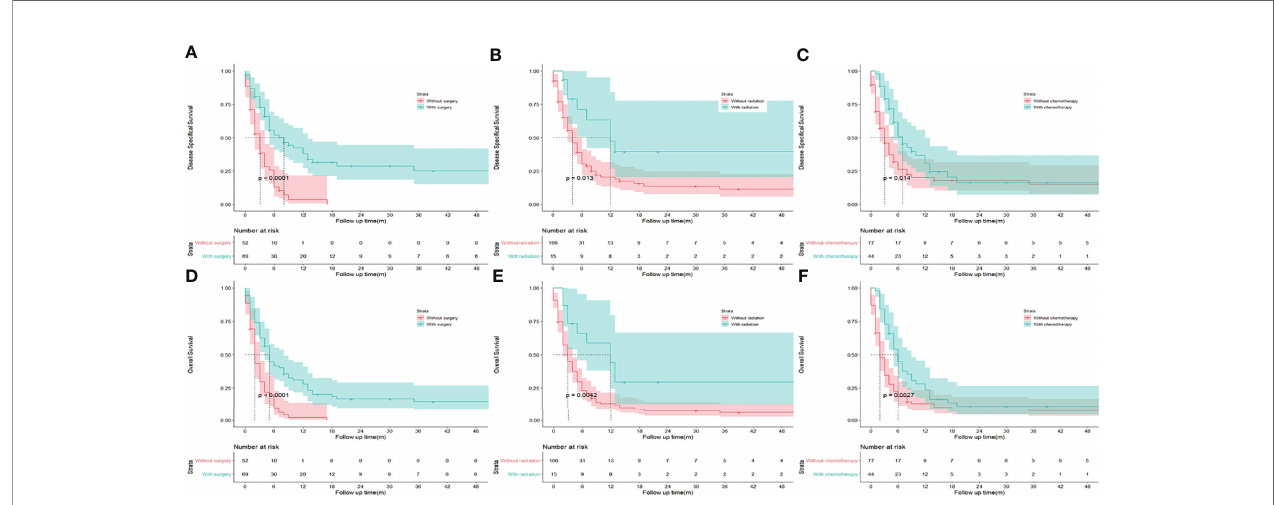
FIGURE 2 | Kaplan-Meier analysis of disease speci fi cal survival and overall survival between patients underwent surgery (A, D) , radiation (B, E) , and chemotherapy (C, F) or not in patients with gallbladder squamous cell